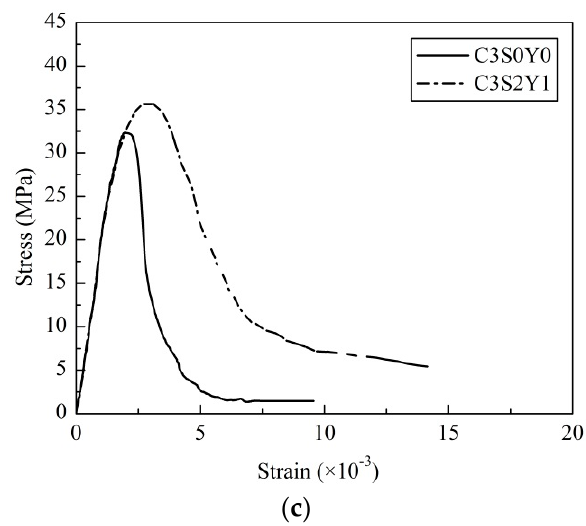
Figure 3. Monotonic stress-strain curves for: ( a ) Group C1 ( f cu = 21.3 MPa); ( b ) Group C2 ( f cu = 25.5 MPa); and ( c ) Group C3 ( f cu = 40.5 MPa).